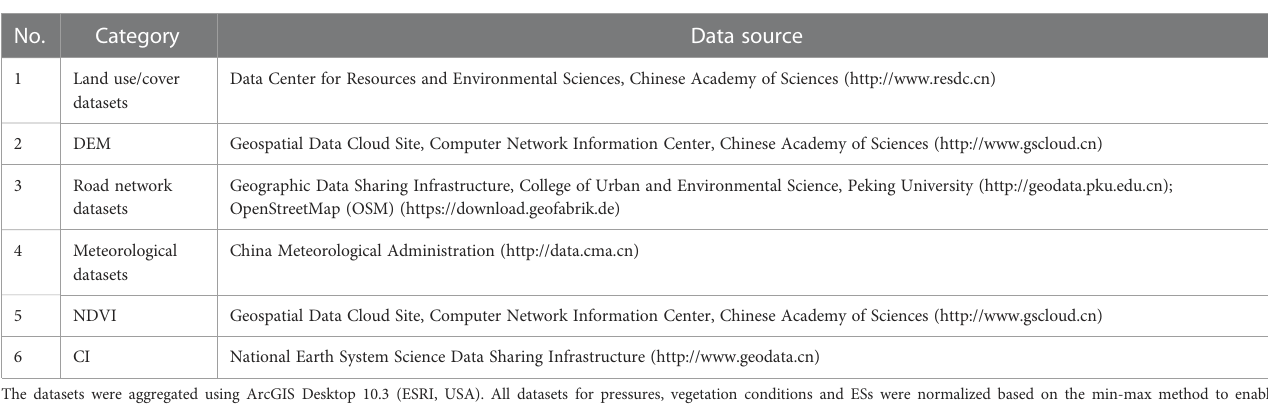
TABLE 1 Principal data sources in the study.